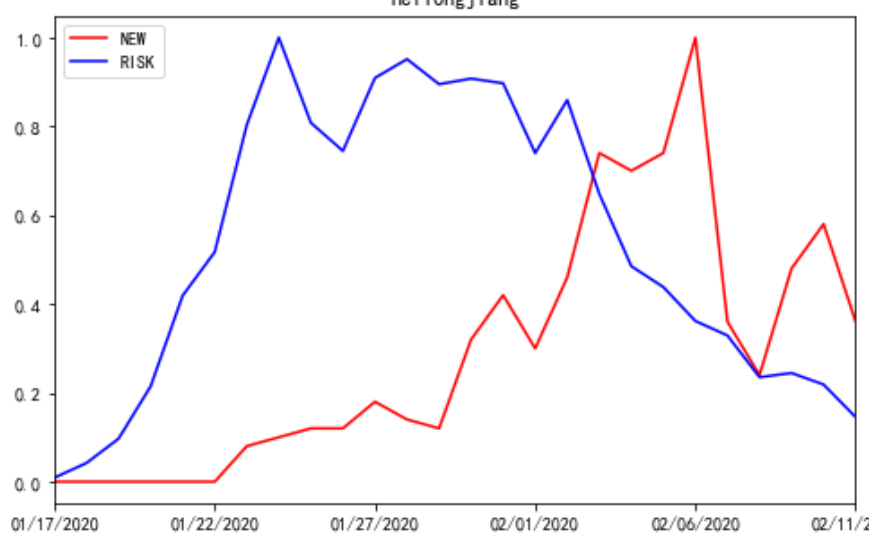
Figure 5. The polyline chart of NEW and RISK for Heilongjiang Province from January 17, 2020 to February 11, 2020.